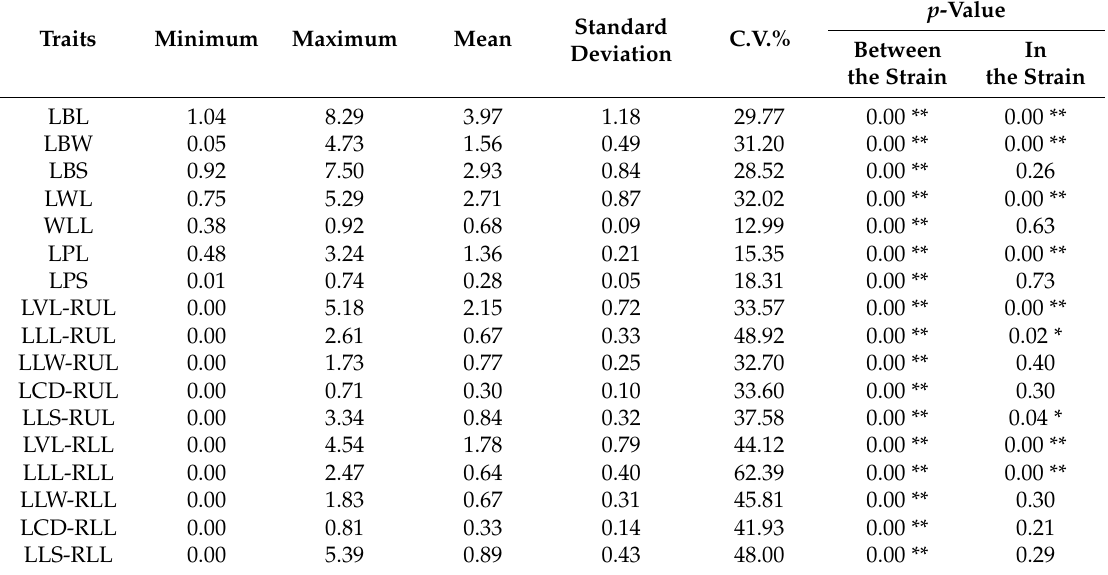
Table 2. The descriptive statistics of 17 quantitative traits.